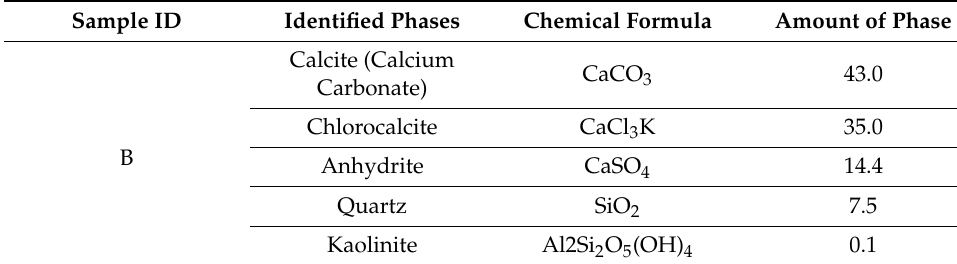
Table 4. Identified phases and their percentage share in the B -sample.